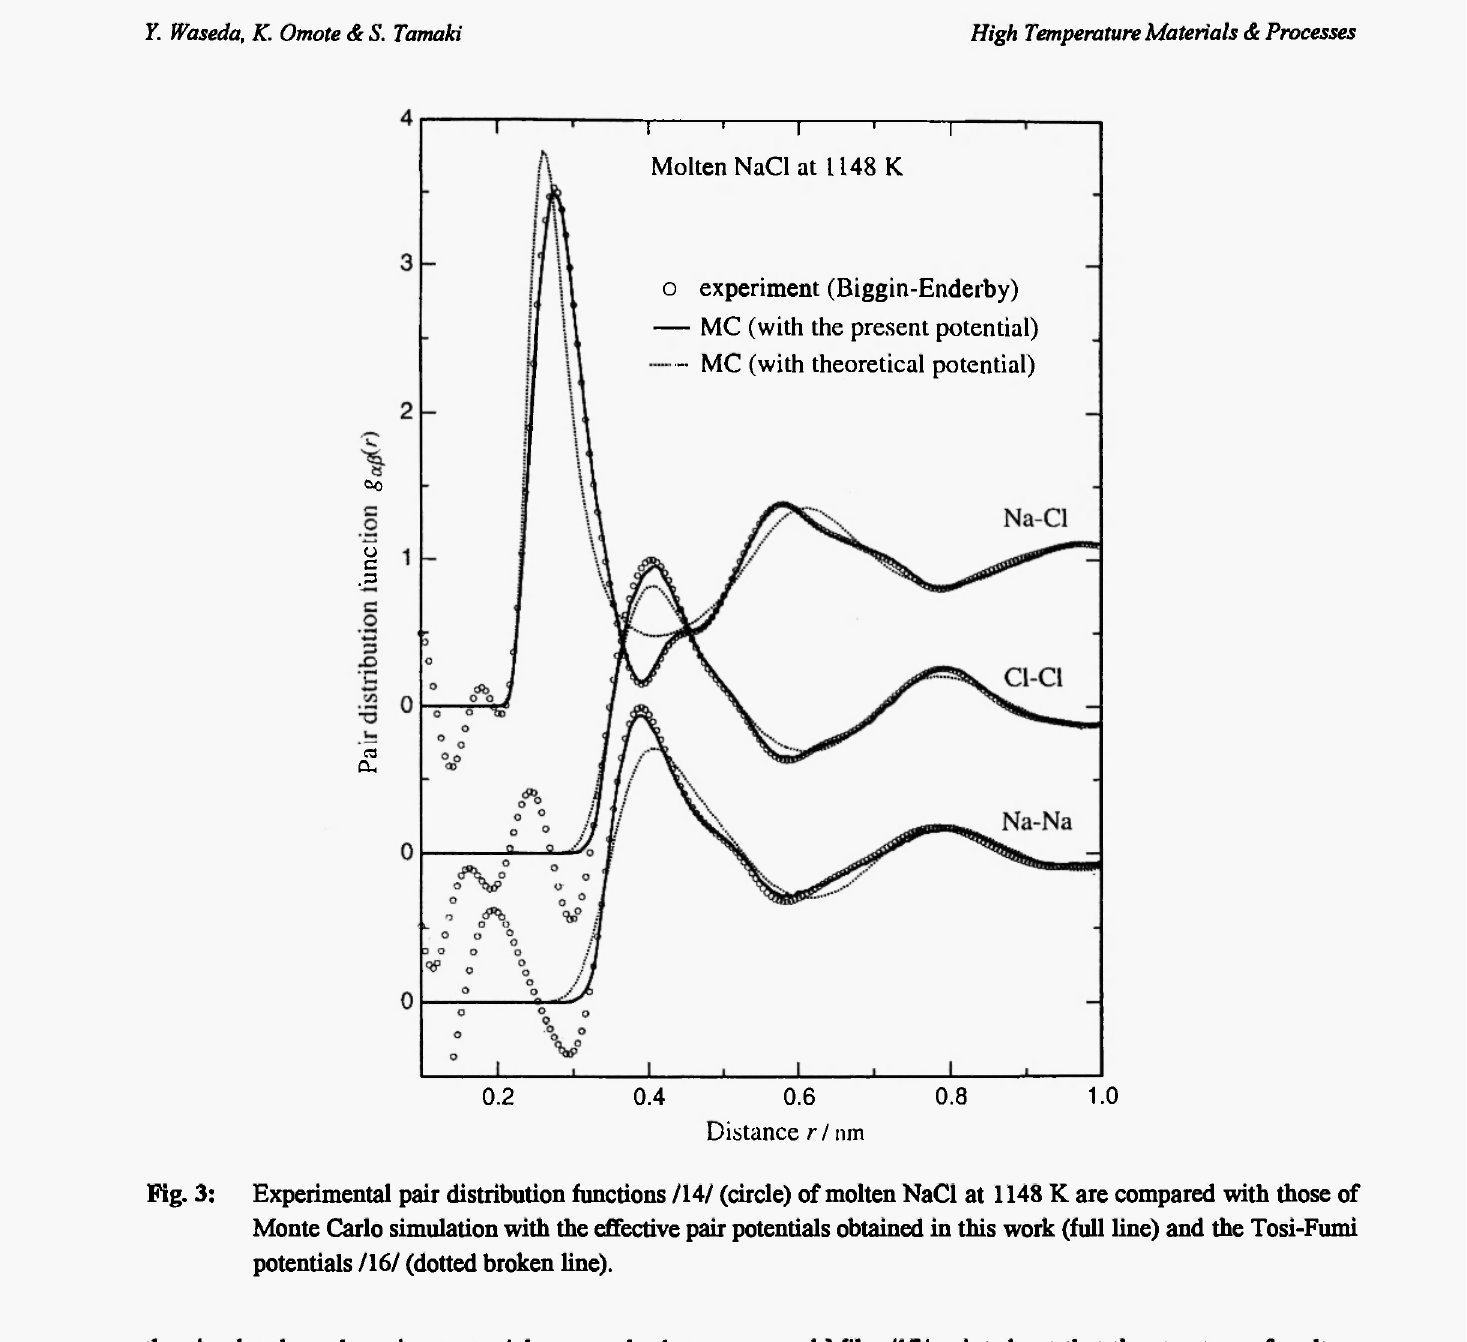
Fig. 3: Experimental pair distribution functions /14/ (circle) of molten NaCl at 1148 Κ are compared with those of Monte Carlo simulation with the effective pair potentials obtained in this work (full line) and the Tosi-Fumi potentials 716/ (dotted broken